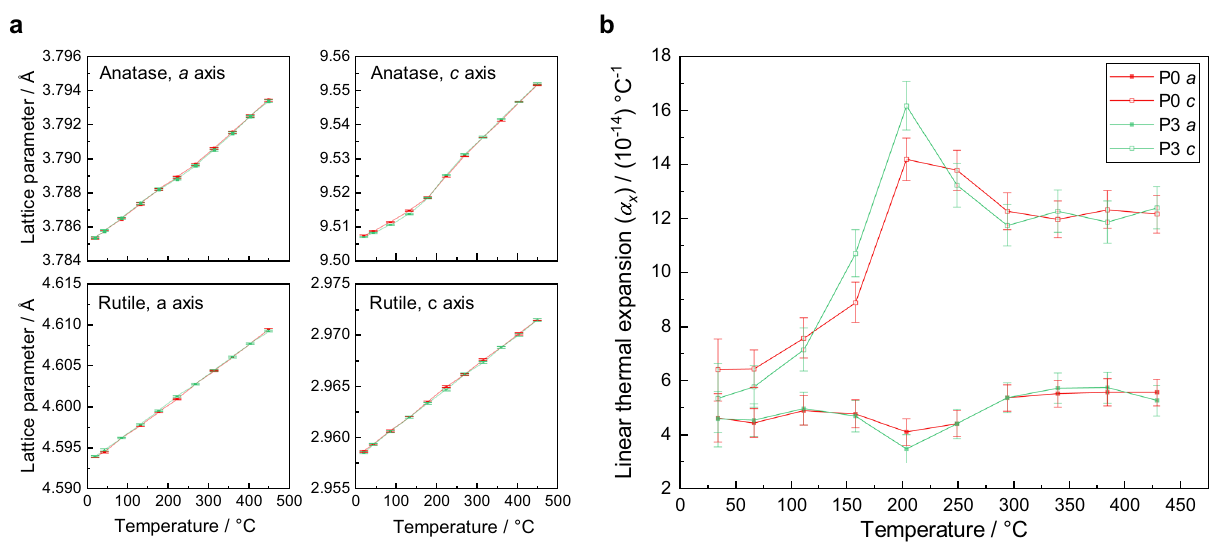
Fig. 4 Thermal expansion of pristine and highly-doped P25 powders. a Lattice parameters of anatase and rutile phases for P0 and P3 from room temperature to 500 °C. b Linear thermal expansion coef fi cient α for the a -axis and c -axis of the anatase phase in P0 and P3. Error bars indicate the standard